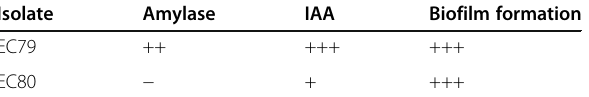
Table 2 Production of amylase and IAA and biofilm formation of bacterial strains Isolate IAA